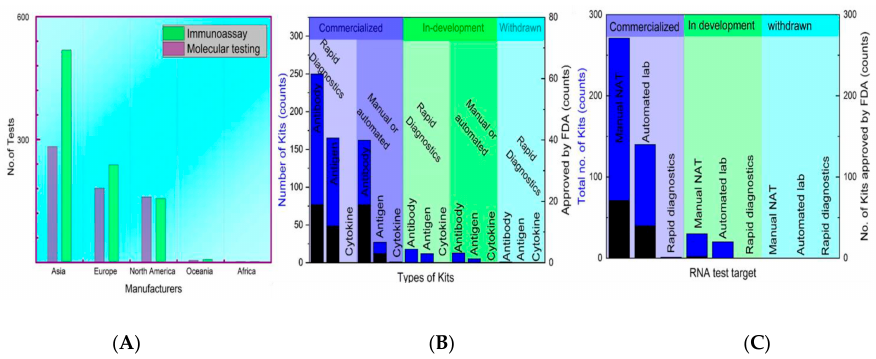
Figure 6. FDA-approved commercial kits: ( A ) The number of testing kits (molecular and Immunoas- say based) produced by the Global manufacturers ( B ) Status of molecular-assay based kits, ( C ) Status of serological assay